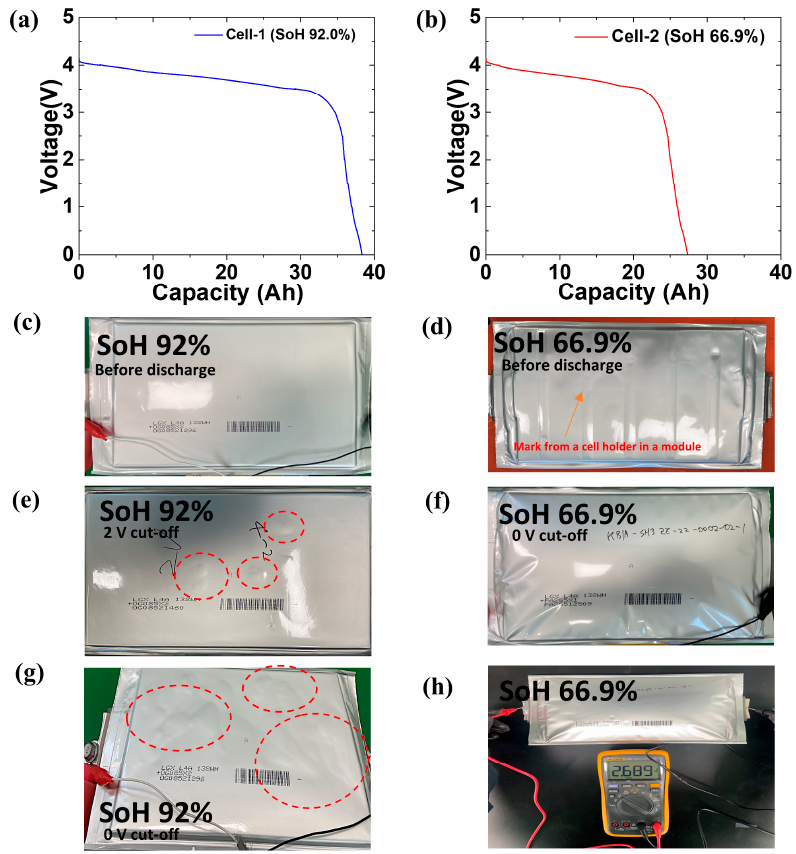
Figure 5. Polarization curve showing the discharge to 0 V of ( a ) cell-1 and ( b ) cell-2. Optical image showing the ( c ) initial state of cell-1, ( d ) initial state of cell-2, ( e ) discharge to 2 V of cell-1, ( f ) discharge to 0 V on cell-2, ( g ) discharge to 0 V cell-1 (red circles indicate the bulges on the surface of a cell-1 pouch). ( h ) Cell potential measurement after 24 h from the discharge to 0 V on a cell-2 pouch. Because cell-2 exhibited a lower SoH and more intensive swelling than cell-1, cell-2 (66.9% SoH), which is suitable for recycling, was subjected to further analysis. Table 2 presents the changes in the outer thickness of the cell based on the discharge voltage. Cell-1 and cell-2 were discharged to 2.5, 2, 1, and 0 V. Once the cells reached the discharge cut-